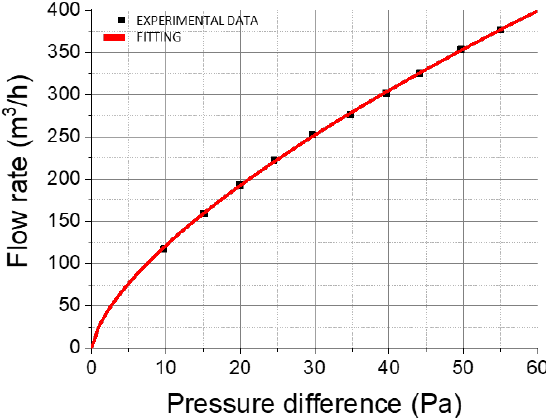
Figure 16. Flow rate of the air leakage as a function of the pressure